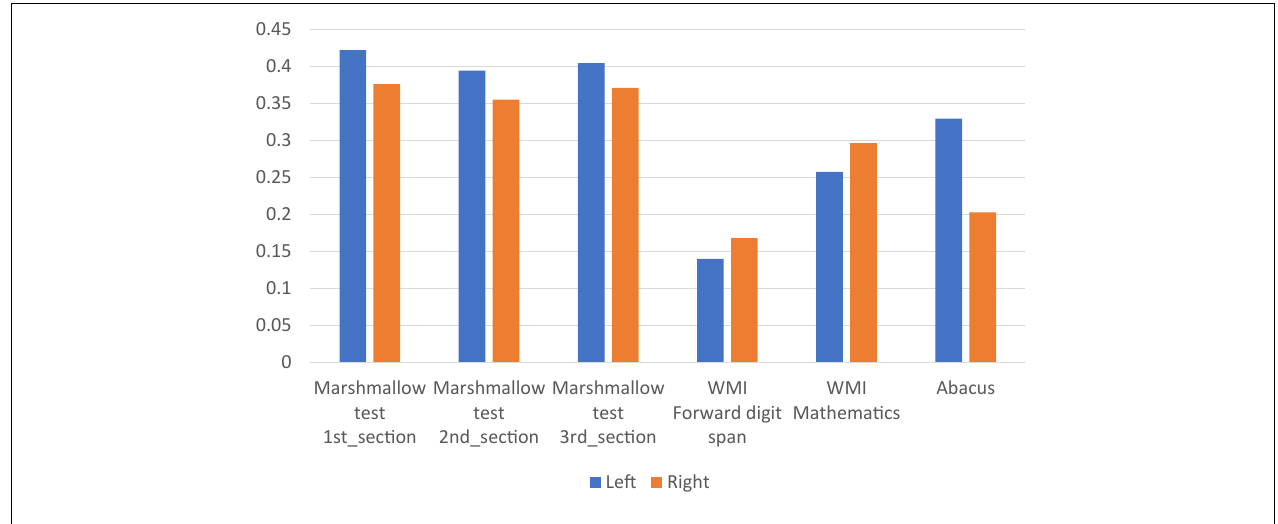
FIGURE 1 | Averages for marshmallow test, forward digit span task, math task, and abacus task.